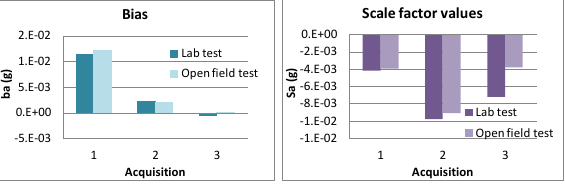
Figure 5. Average values of bias and scale-factor for laboratory and open field calibration tests